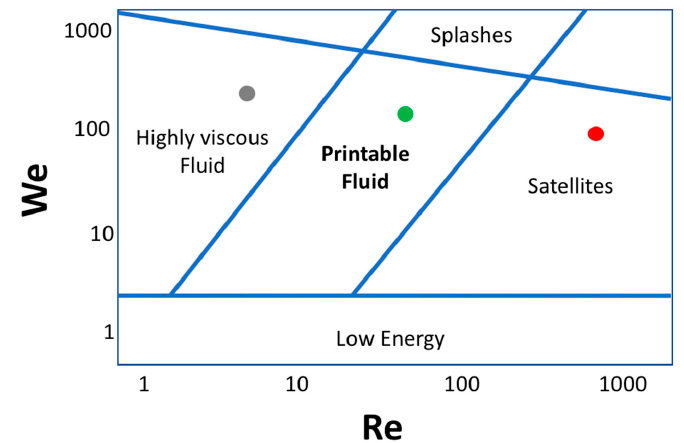
Figure 7. Derby plot giving information on the fluid printability regimes as a function of Weber ( We ) and Reynolds ( Re ) numbers. The coordinate system illustrates the physicochemical combination of fluid properties that determine a good quality inkjet printing process. The area containing the red dot represents experimental conditions corresponding to satellite-forming inks, the grey dot labels the regime of high-viscosity inks, while the green dot represents a well-printable ink regime. At the lowest and highest values of We , the printability of the inks is generally reduced for lack of energy needed to induce the drop formation and ejection, and because of splashing phenomena after the impact of the drops with the solid interface, respectively.